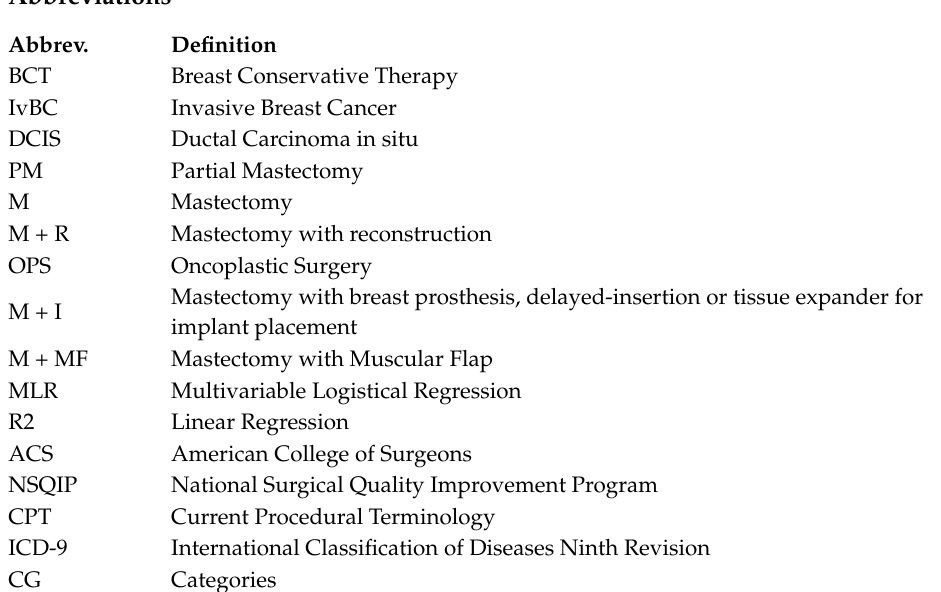
Figure S1: Methods Schematic, Table S1: CPT Codes use to Categorize Breast Cancer Intervention, Table S2: Data from NSQIQ database. Table S3: Unadjusted Logistical